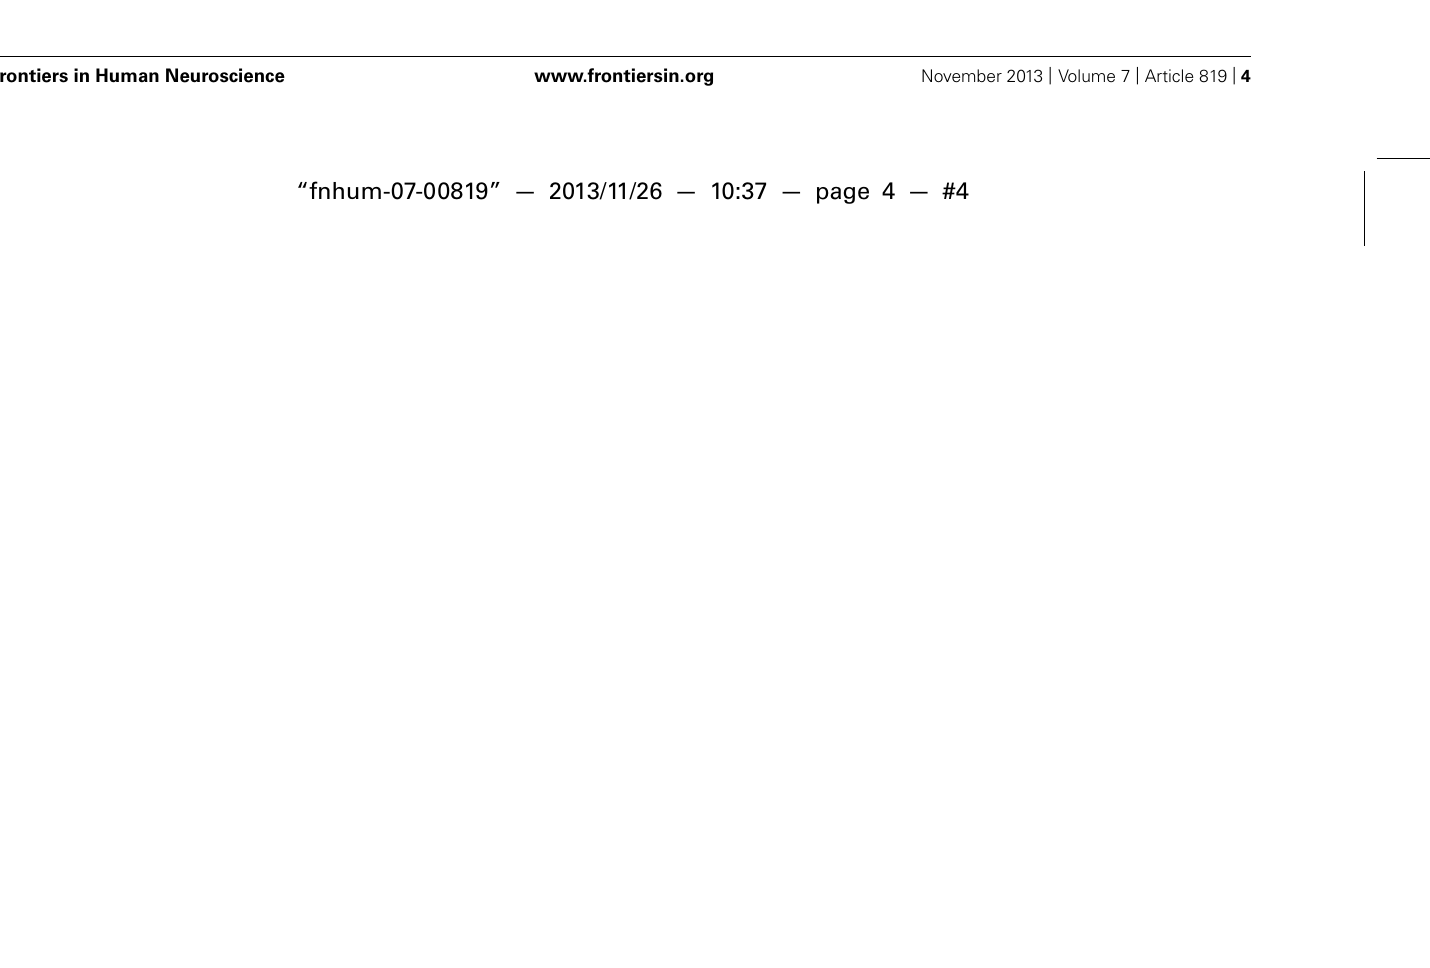
experts (see Table 3 ) during observation of the early occluded clips.The individual plots confirm that experts and novices are using separate neural networks during successful anticipation of actions.